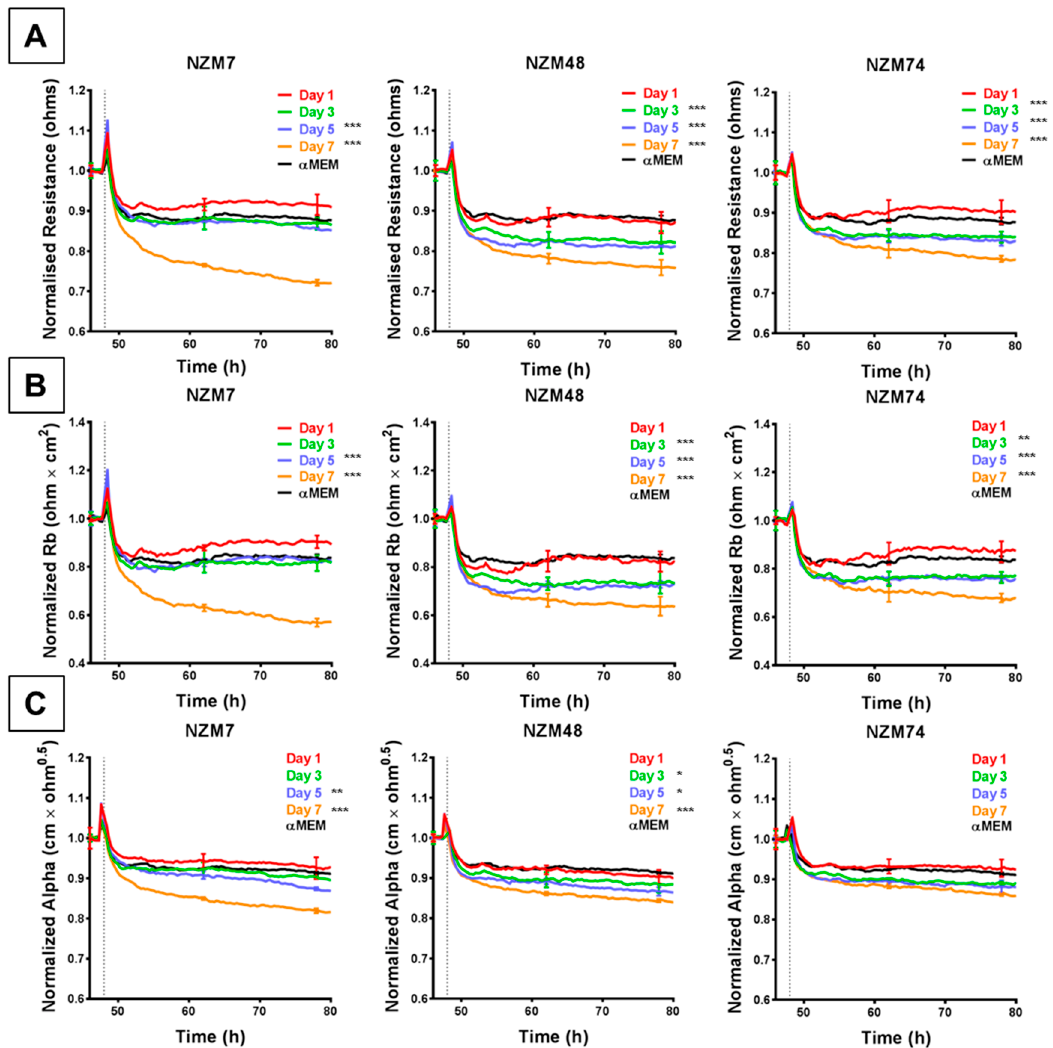
Figure 5. ECIS reveals that melanoma cell (NZM7, 48 and 74)-conditioned medium (CM) disrupts hCMVEC paracellular and basolateral resistance. ( A ) Unmodelled resistance (at 4000 Hz) of hCMVECs over time after addition of CM from NZM cell lines. Modelled ( B ) paracellular resistance (Rb) and ( C ) basolateral resistance (Alpha) of hCMVECs over time after addition of CM from NZM cell lines. NZM CM was added at 48 h (dotted line). α MEM is medium-only control. Data shown as mean ± SD ( n = 3 wells) from a single experiment; Endpoints from three independent experiments were compared relative to their media control using two-way ANOVA with Tukey’s range test (* p < 0.05, ** p < 0.01, *** p < 0.001).